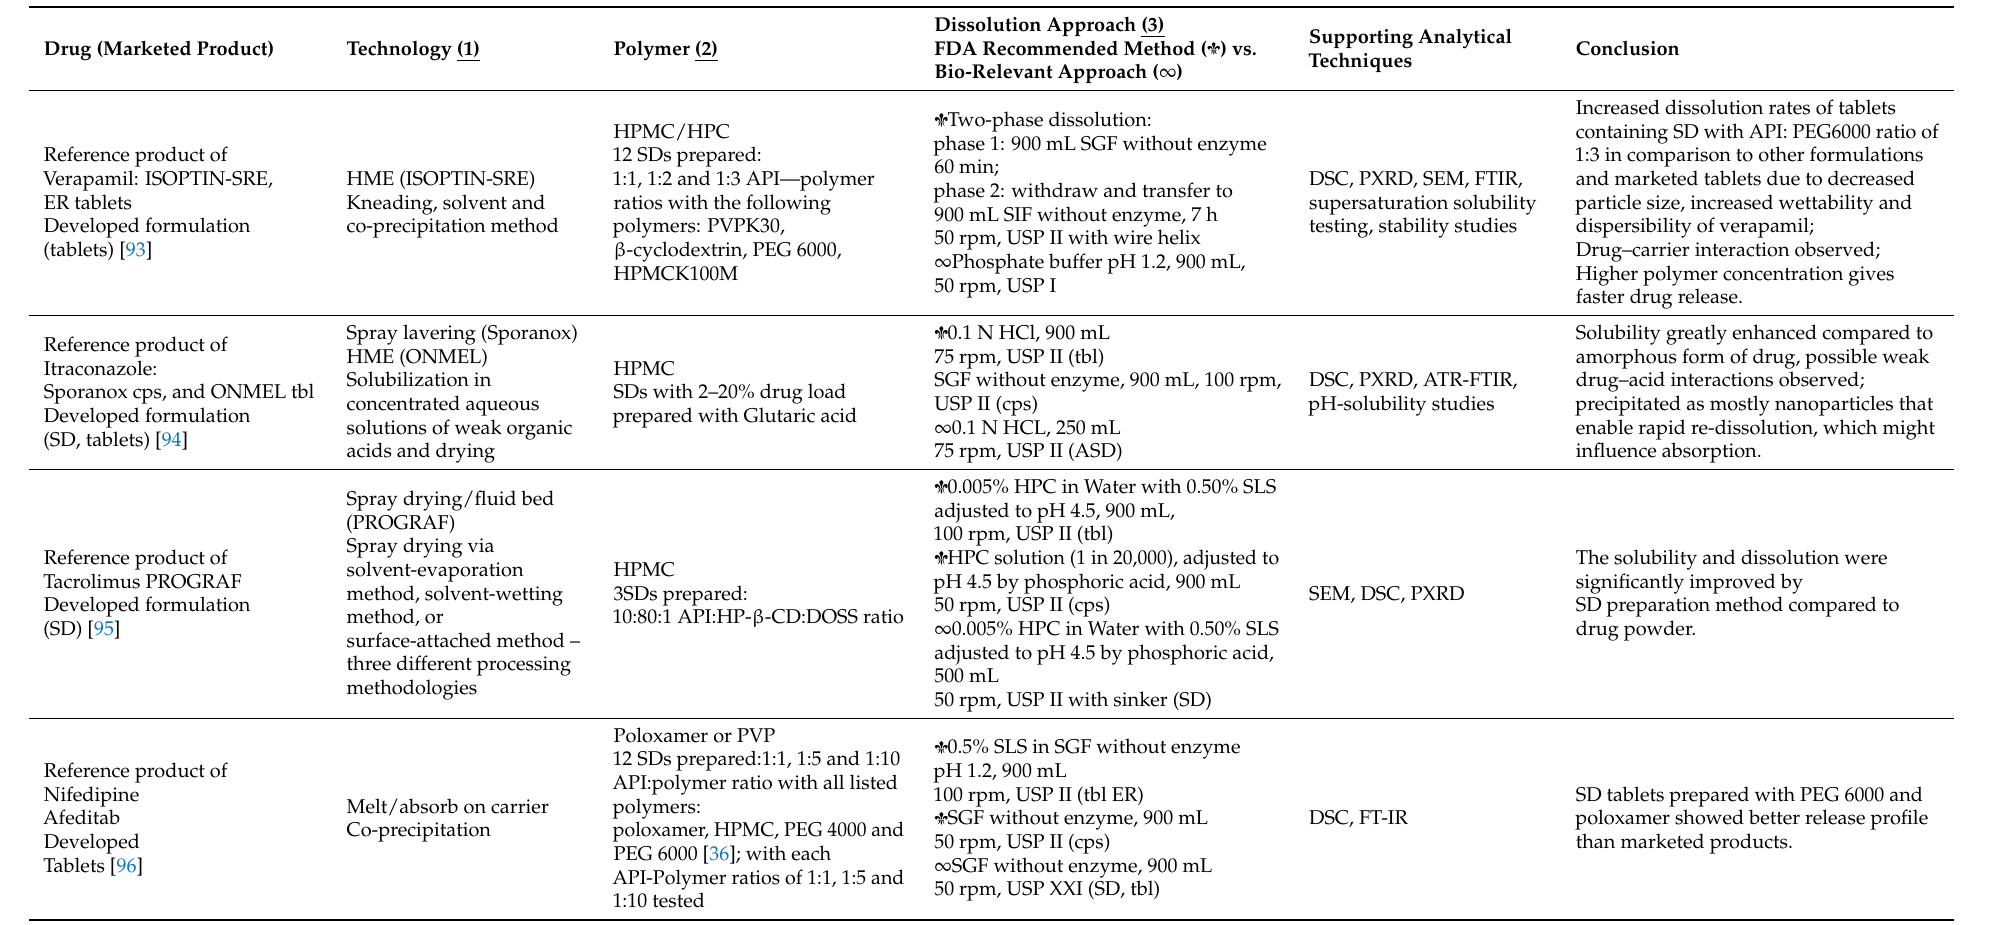
Table 2. Review of dissolution studies on amorphous solid dispersion formulations.